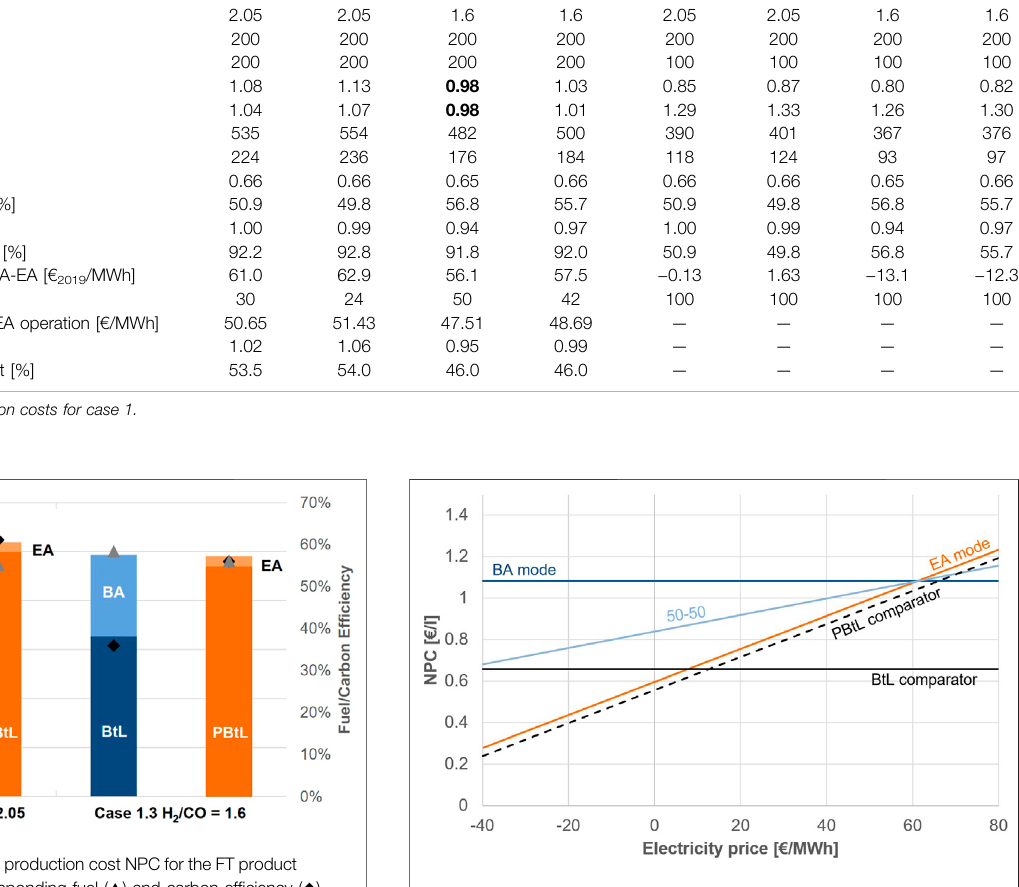
FIGURE 7 | Variation of electricity price for case 1.1 EA and BA mode in comparison to BtL and PBtL. The light blue line (50-50) signi fi es the production costs if the process is operated half a year in BA